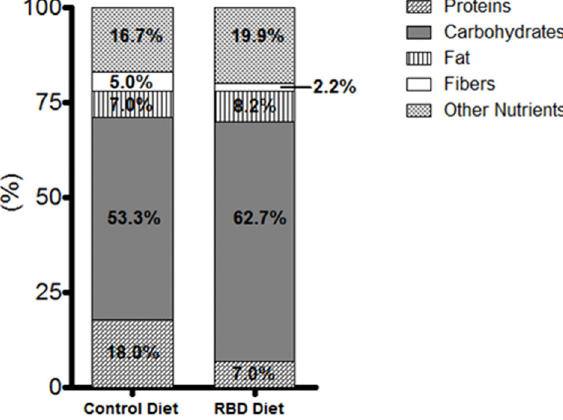
Figure 1 . Composition of the regional basic diet (RBD) and control diet reported as percent of total calories. The RBD diet contains a higher amount of carbohydrates and lower quantity of protein than the control